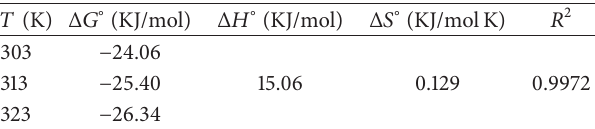
Figure 16: Plot of ln 𝑏 versus 1/𝑇 for biosorption of MB onto PTMF. Table 7: Values of thermodynamic parameter for the adsorption of MB onto PTMF.